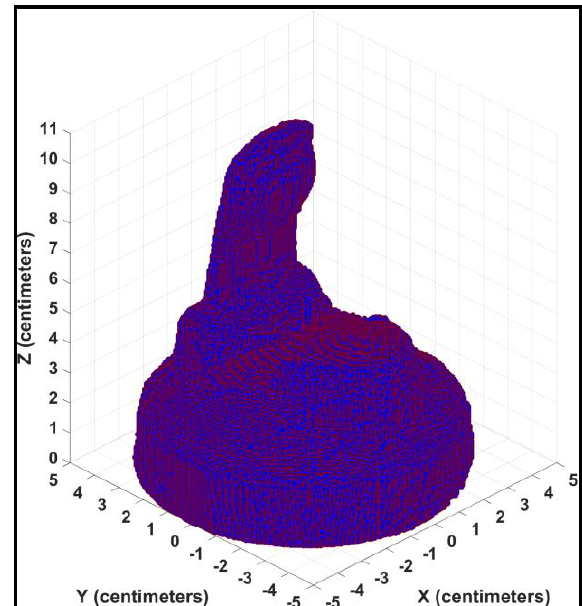
Figure 7. Reconstructed model (view 1)